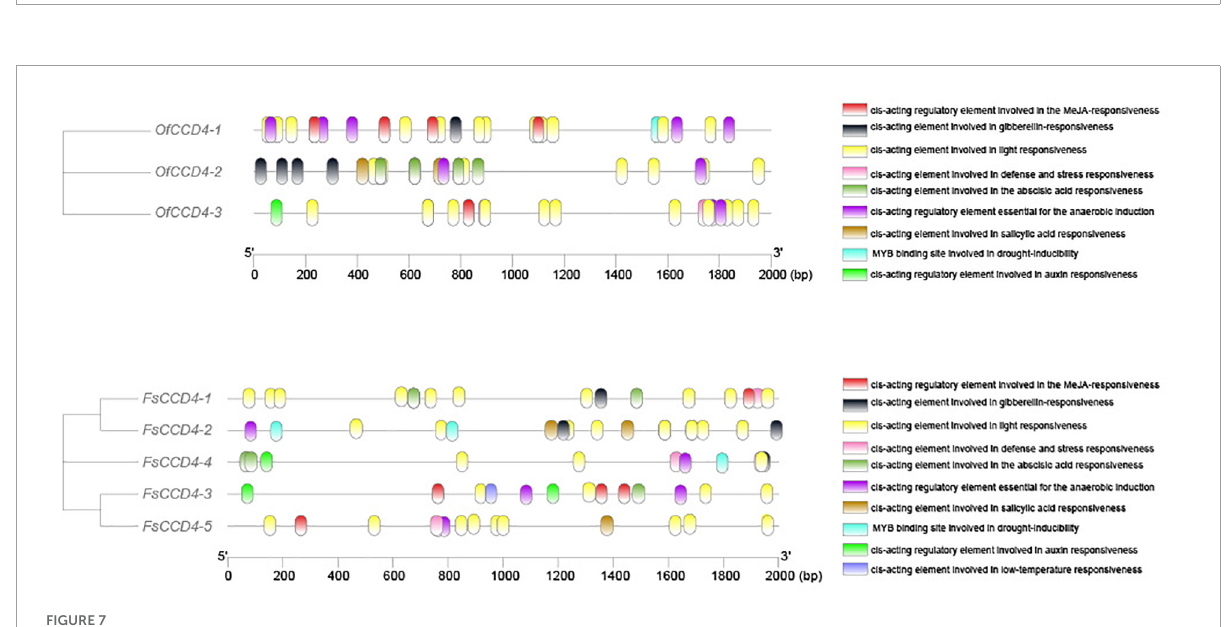
Frontiers in Plant